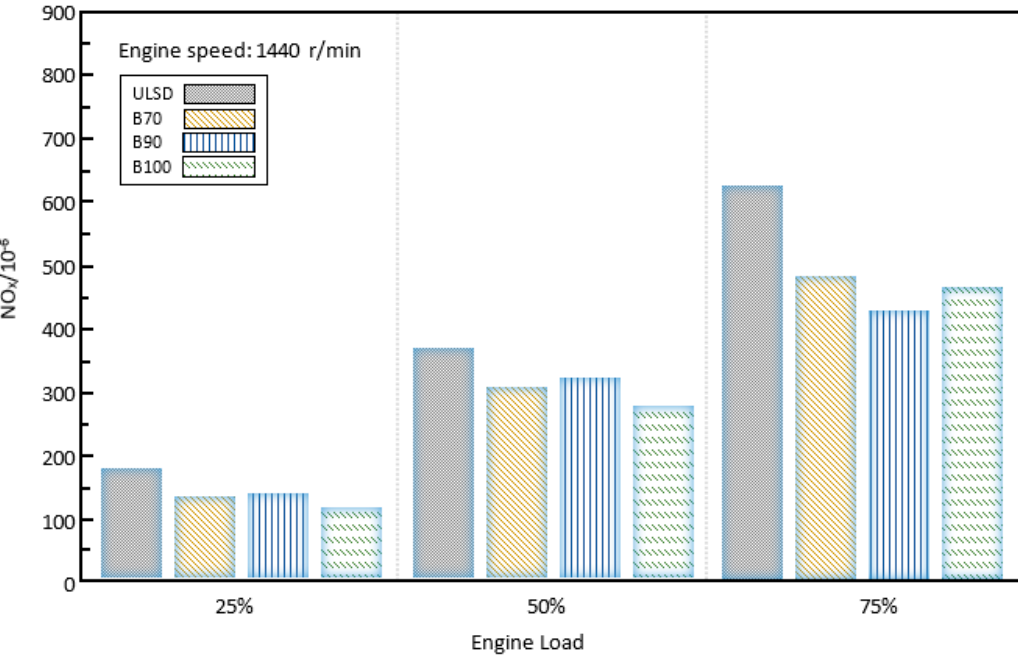
Figure 11. Tested fuels’ influence on the exhaust gas temperature at 1200 rpm . Higher generation of NOx emissions during engine operation relates to increasing engine speed and loads. Emissions values can reach a maximum of about 670 ppm in the case of ULSD-F and nearly 465 ppm in the pure biodiesel regime (Figure 11). With rising